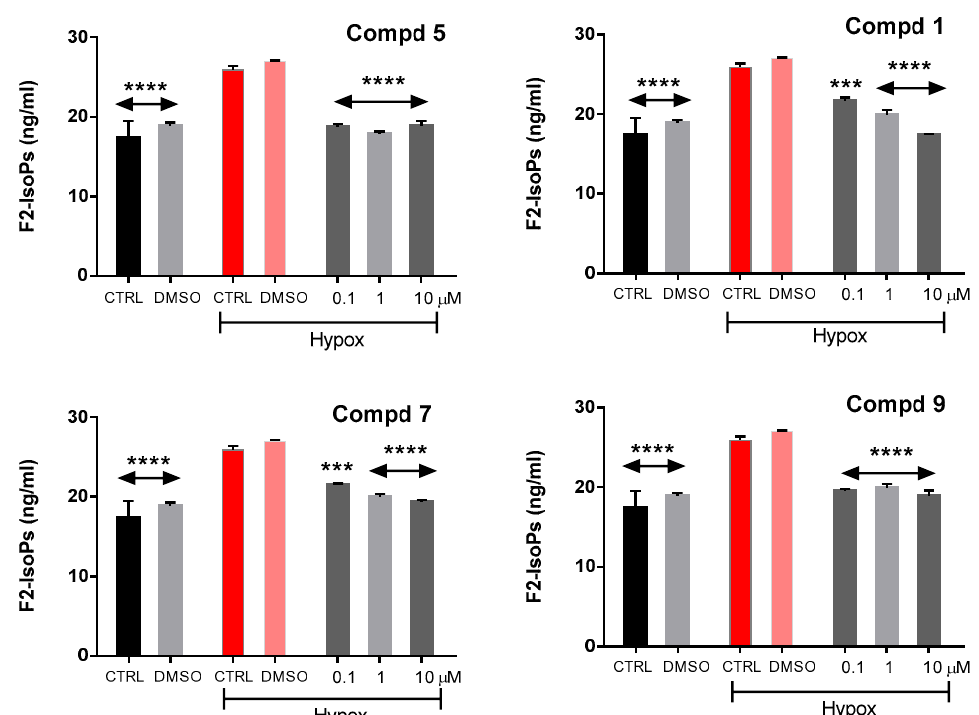
Figure 5. Concentration of total F2-isoprostanes (F2-IsoPs) measured in HaCat cells after 48 h hypoxia (2% O 2 , 5% CO 2 and 93% N 2 ) or normoxia in the absence (CTRL) or presence of capsaicin or compounds 1 , 4–5 , 7 and 9 (dissolved in DMSO). Each point represents the mean ± SEM of five independent experiments. (ANOVA and Bonferroni post hoc-test). *** p < 0.001; **** p < 0.0001 vs. CTRL hypoxia.